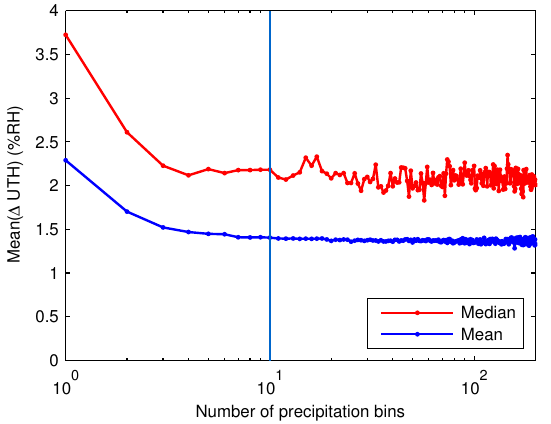
Figure 9. Effect of precipitation binning. Change in UTH ( (cid:49) UTH = UTH(AOD ≥ 0.18) − UTH(AOD < 0.18)) as a function of the number of precipitation bins over which the average is calcu- lated for the data east of China in June, July and August in 2007– 2013. Here, only the precipitation values of more than 1mmday − 1 were taken into account. The cirrus dependence has been removed from the AOD data. When no precipitation binning was applied, or when only a few bins were used, the increase in UTH was clearly larger than when at least 10 bins were used. This indicates that the precipitation binning is essential if we want to remove the effect of convective invigoration on UTH. In this study, we used 10 precip- itation bins (indicated by the vertical line in the figure) in order to remove the influence of invigoration on our